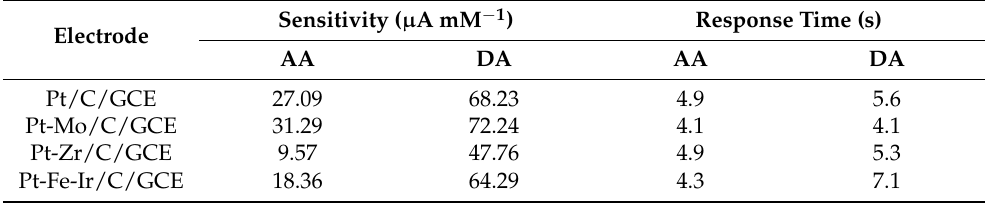
Table 3. Comparison of sensitivity and response time for various